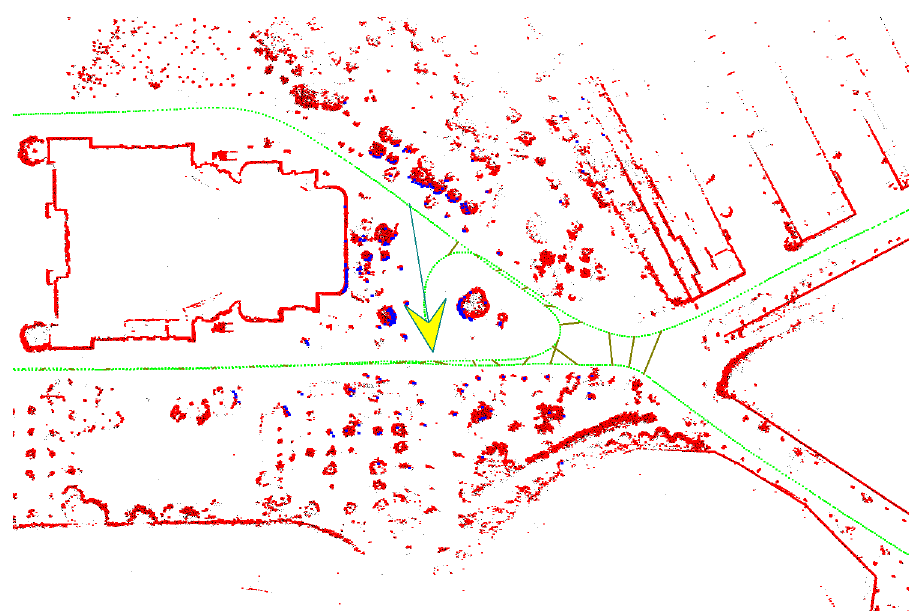
Figure 13. The mapping process visualization. The red points are obstacles mapped online; the blue points represent the current laser scan; the green points represent the vehicle trajectory and the dark yellow lines are the loop